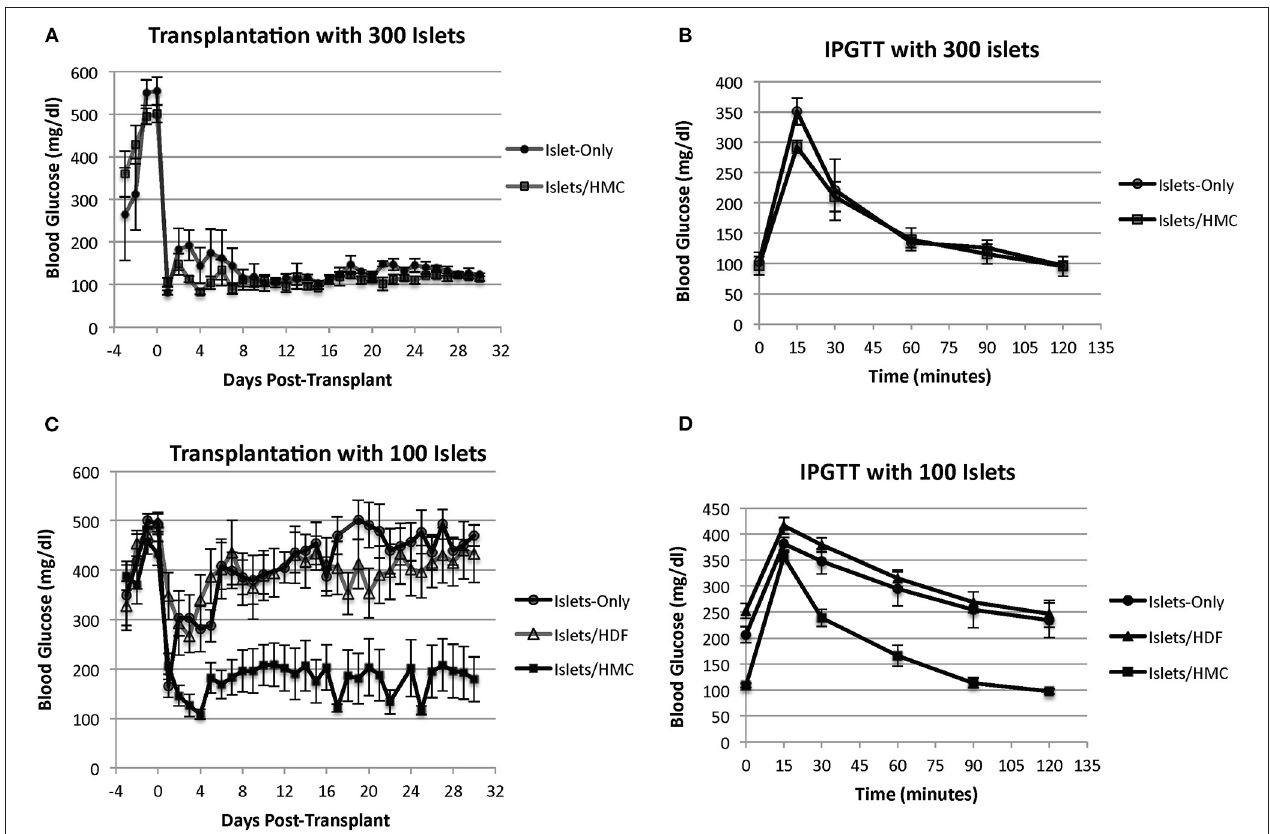
FIGURE 2 | (A) Blood glucose levels of mouse recipients following transplantation of 300 islets under the kidney capsule with ( N = 4) and without ( N = 3) HMCs. Day 0 = day of transplant. (B) IPGTT glycemic curves of the same recipients performed at 2 weeks post-transplant. (C) Blood glucose levels of mouse recipients following transplantation of 100 islets. Day 0 = day of transplant. Recipients of islets alone ( N = 8), islets plus HMCs ( N = 8), and islets plus HDFs ( N = 7) Values are means ± SEM. Differences between 100 islets plus HMCs in recipients and the other two control groups are statistically significant ( p < 0.001). (D) IPGTT glycemic curves of the same recipients performed at 2 weeks